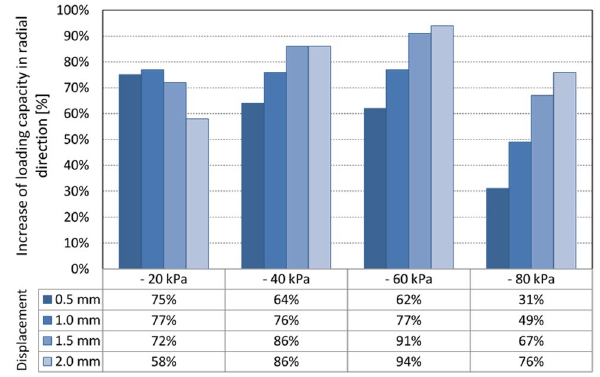
Fig. 26 Gripping element (without supporting plate orientation